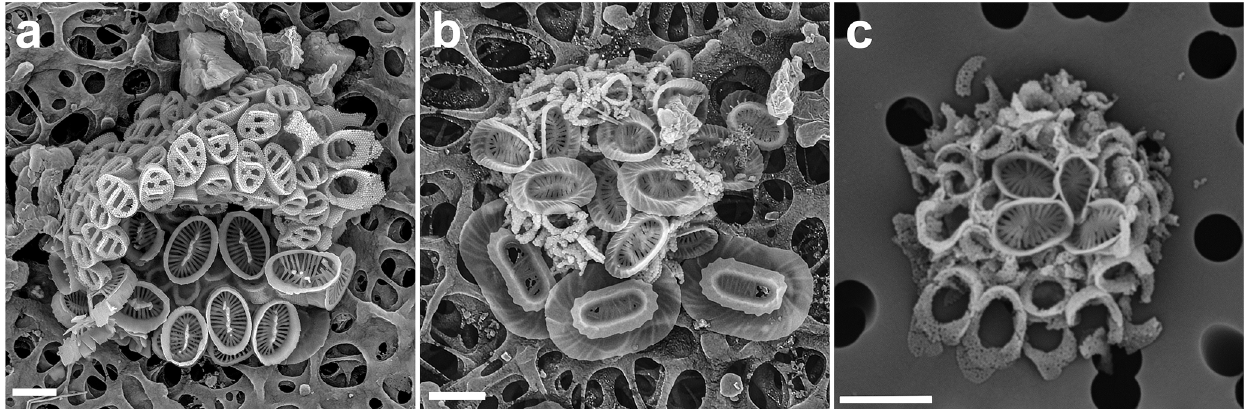
Figure 8. New combination coccospheres in the genus Syracosphaera . (a) Below are body coccoliths of S. lamina (and one exothecal coccolith in the bottom right), and above are Poricalyptra aurisinae body coccoliths with the typical four transverse openings and circum- flagellar coccoliths (GoN, 12 August 2016, 60m). (b) S. azureaplaneta and Corisphaera sp. (GoN, 9 March 2017, 1m). (c) S. orbiculus with Corisphaera sp. (GoN, 28 March 2017, 20m). Scale bars: